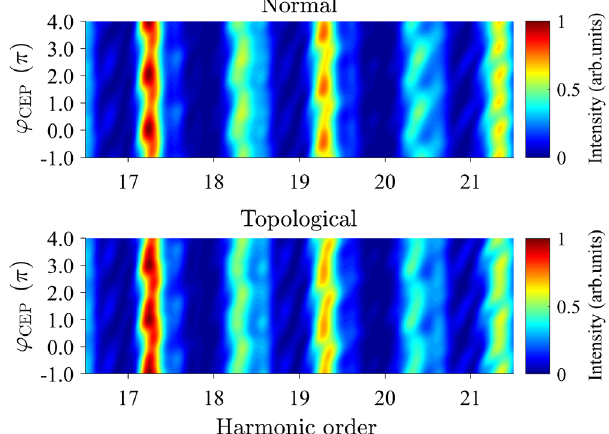
FIG. 10. CEP dependence of normalized HHG spectra for the NP and TP points. The CEP shift of π between the two spectral structures originates from the reversal of the shift